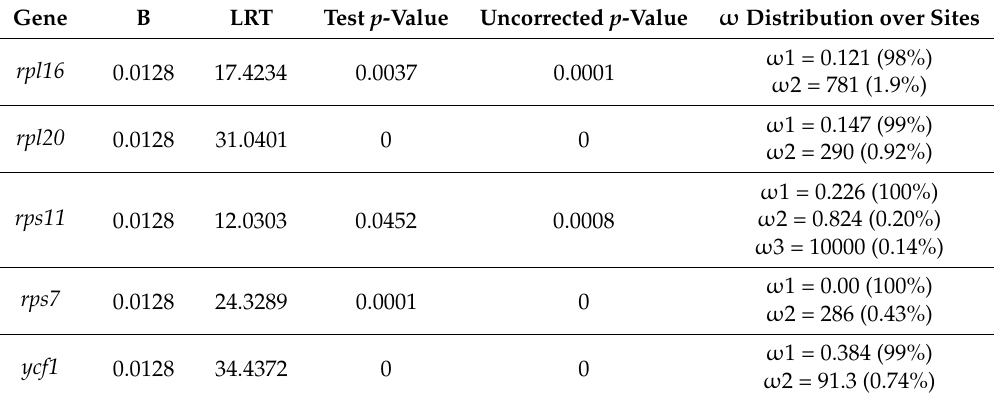
Table 3. The results of positive selection genes at Caragana